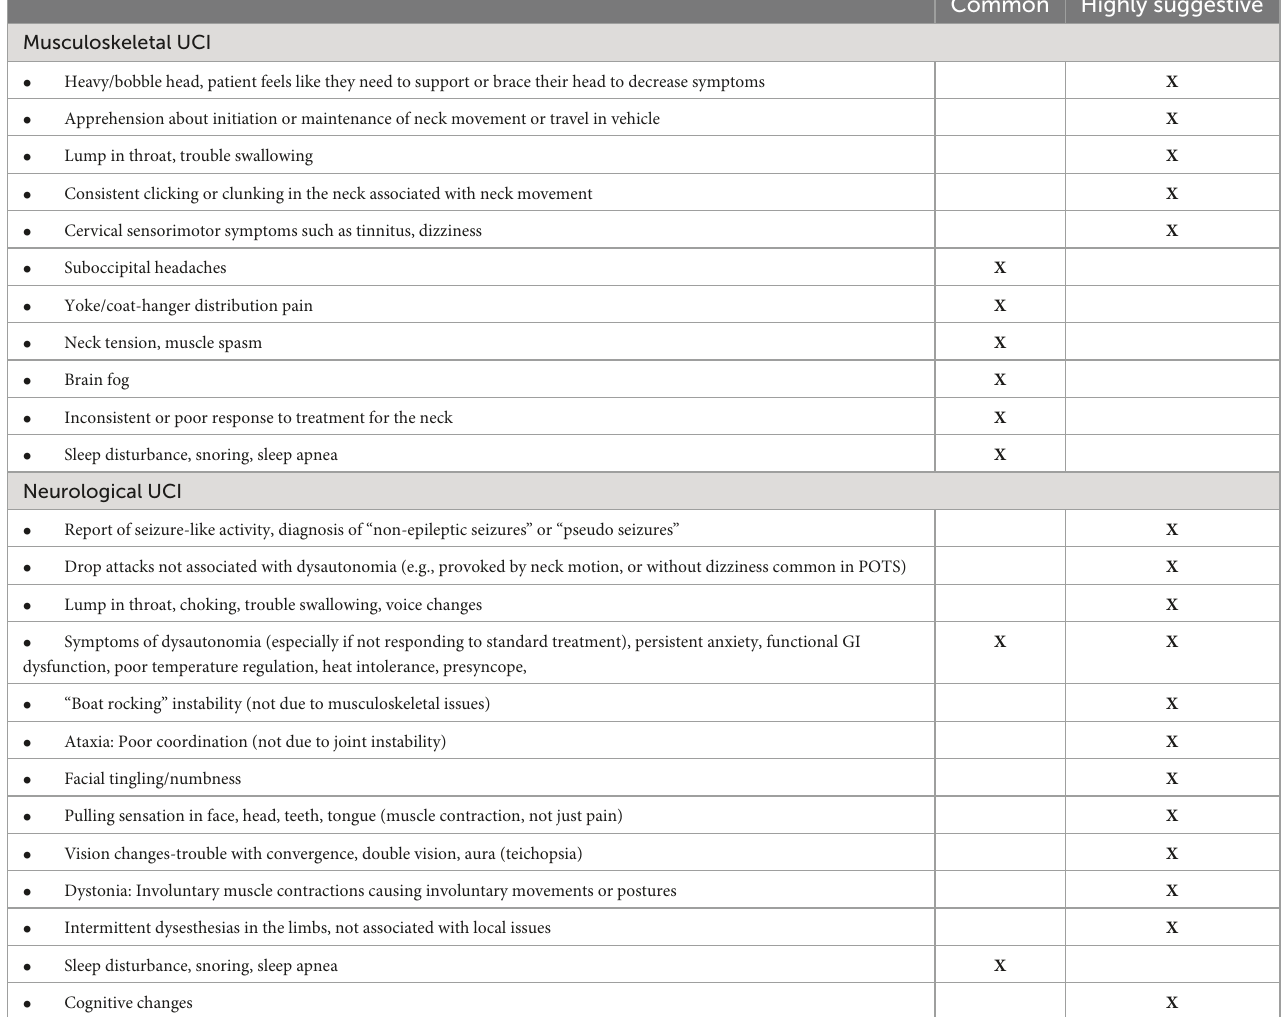
Common Highly suggestive